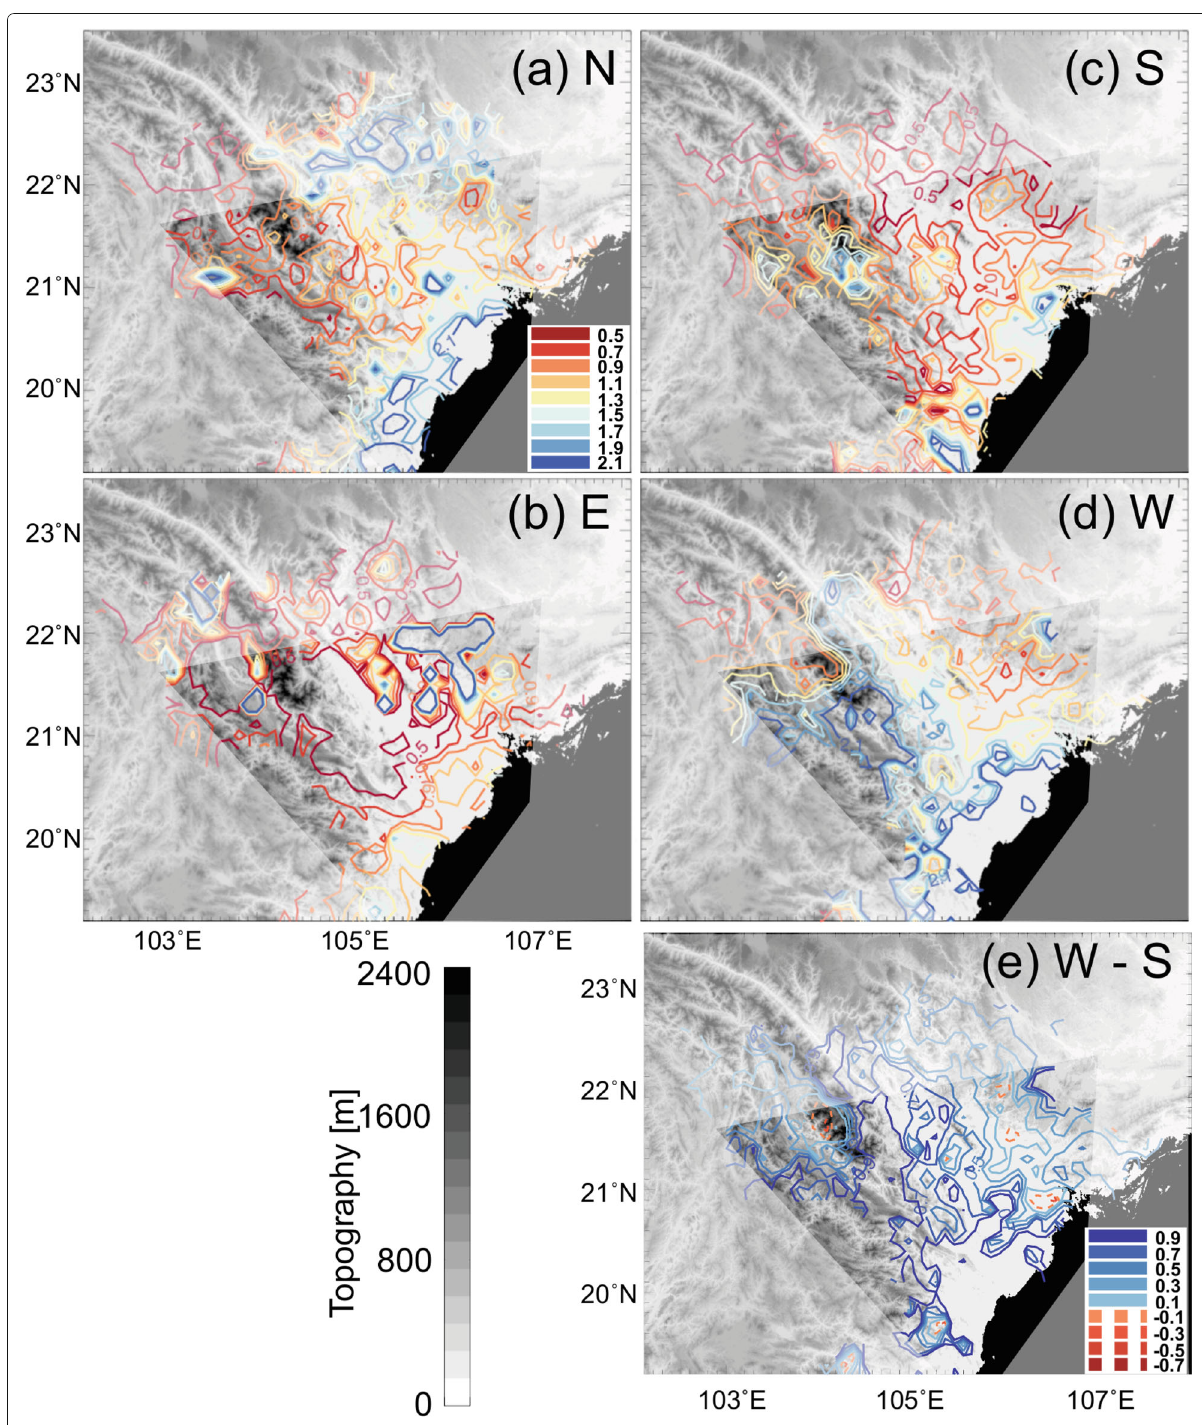
Fig. 5 Horizontal distribution of GSMaP performance for the period May–Aug., in 2000–2010. GV ratios in a northerly, b easterly, c southerly, and d westerly 850 hPa wind cases, at Hanoi, are shown with contours (interval 0.2). The wind direction range in panels a , b , c , and d are 315 − 360 ◦ and 0 − 45 ◦ ,45 − 135 ◦ ,135 − 225 ◦ ,and225 − 315 ◦ , respectively. e The difference between d and c , with contours (interval 0.2). Broken and solid lines show negative and positive values, starting at values of ?0.1 and 0.1, respectively. The regions outside the quadrilateral region enclosed by the four Hanoi area radiosonde stations (Vinh, Bach Long Vi, Dien Bien Phu, and Nanning, see Table 2) are shown with paler colors. The four stations show higher correspondence in their zonal wind components with Hanoi, as summarized in Table 2. The horizontal resolution is 0.1